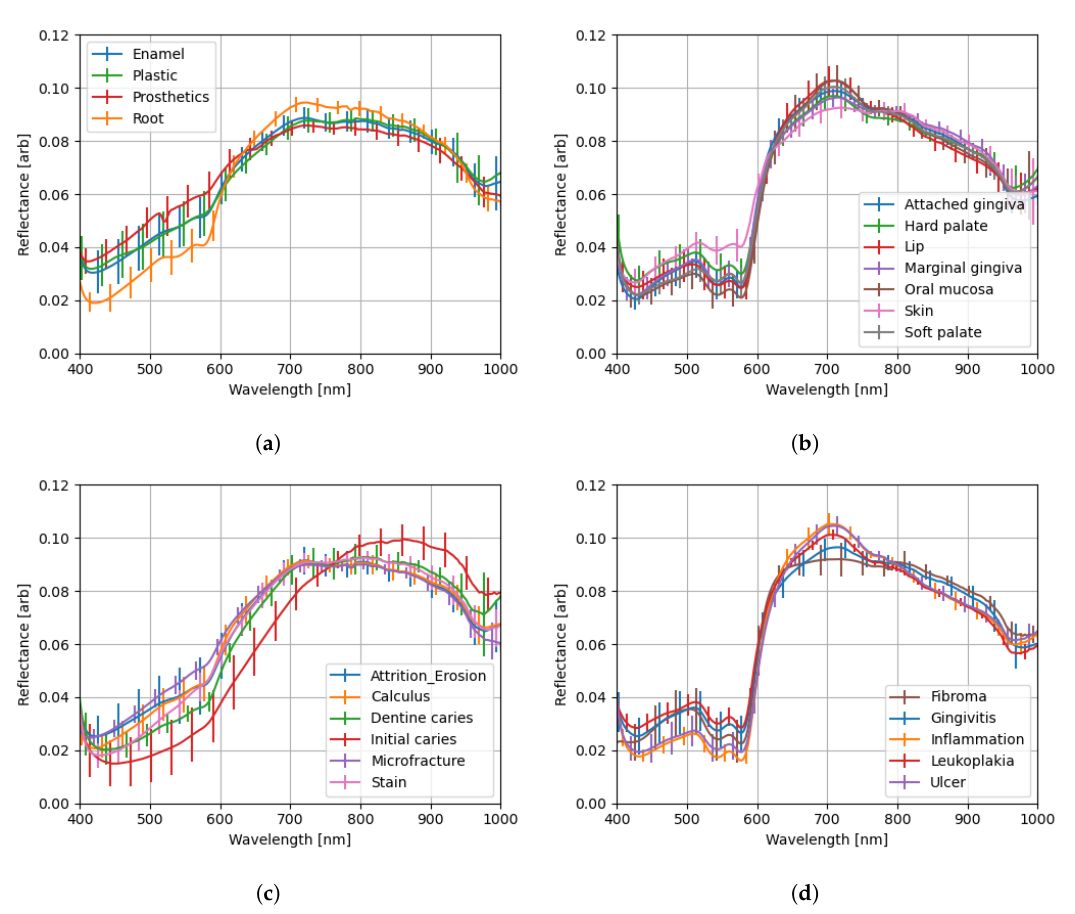
Figure 9. Means of L 2 -normalized spectra acquired with Specim IQ spectral camera, and their standard deviations for ( a ) hard tissue, ( b ) soft tissue, ( c ) hard tissue lesions, and ( d ) soft tissue